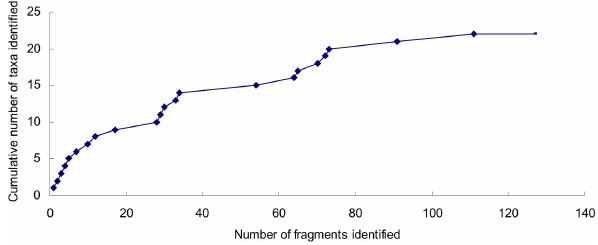
Fig. 3. Identification saturation curve of fossil charcoal from the Dadiwan site,